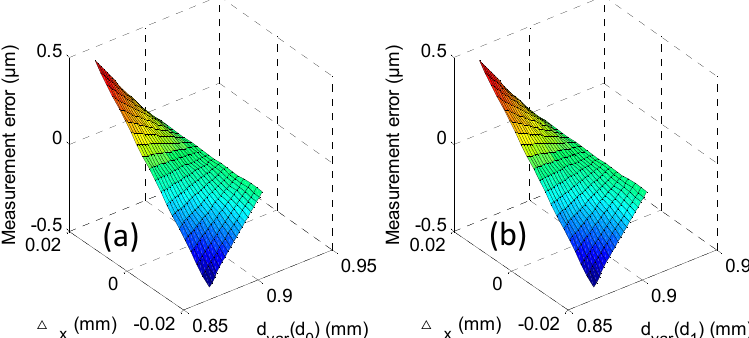
Figure 5. Measurement errors along the X-axis with different d var values and actual shift value Δ X along the X-axis for a point source: ( a ) variation of d var with d 0 , and ( b ) variation of d var with d 1 .